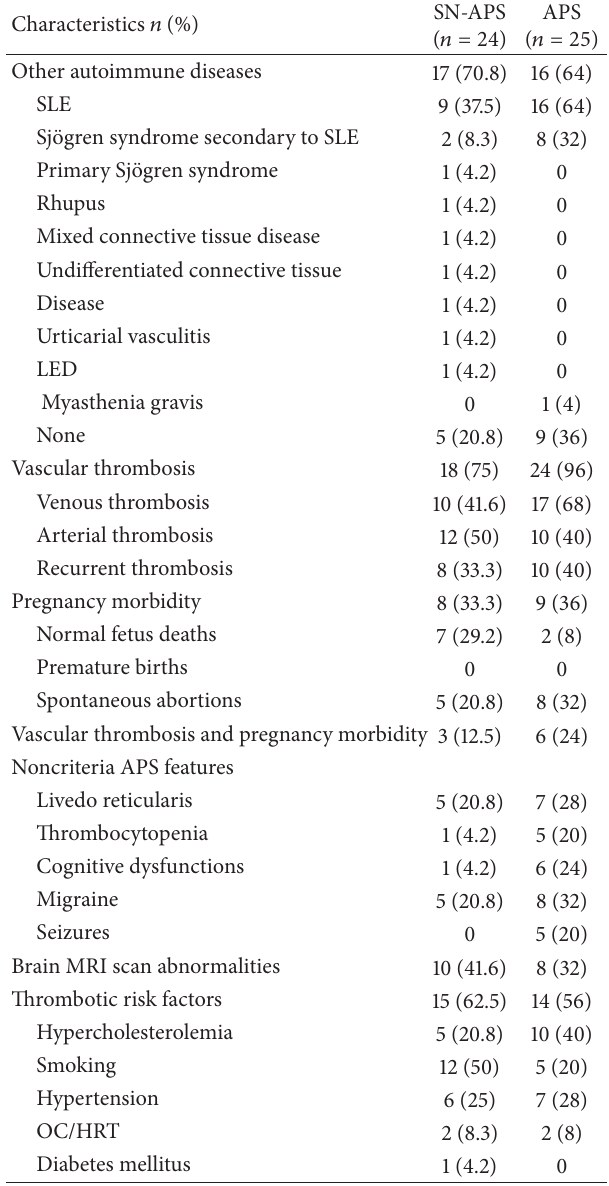
Table 1: Clinical characteristics of patients